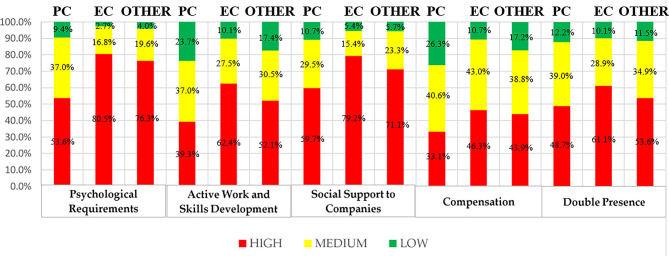
Risk levels by dimension and service (CoPsoQ-istas21).